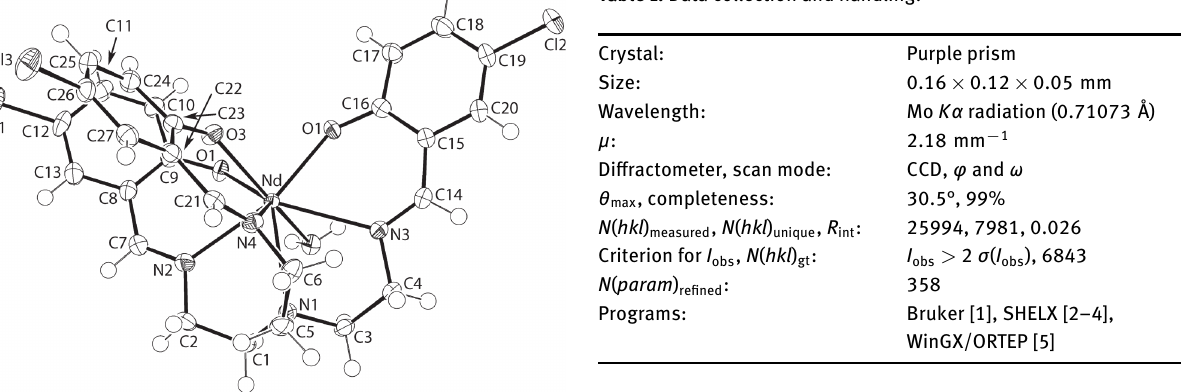
Table 1: Data collection and